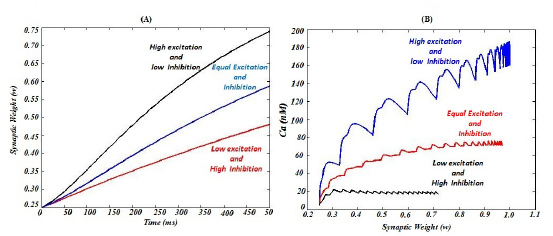
Figure 7. Synaptic learning rule. Level of the calcium concentration is strongly associated with the synaptic weights. Panel (A): Red line, inhibition is 10 times higher than excitation, so the synaptic connections are weak, black line, excitation is 10 times higher than inhibition, so a strong connection exist and finally the blue line, inhibition and excitation are at the same activity level, so as a result the synaptic connections are somehow in the medium range. Panel (B): The relationship of the Ca 2+ modulation on the synaptic connection. More Calcium means strong